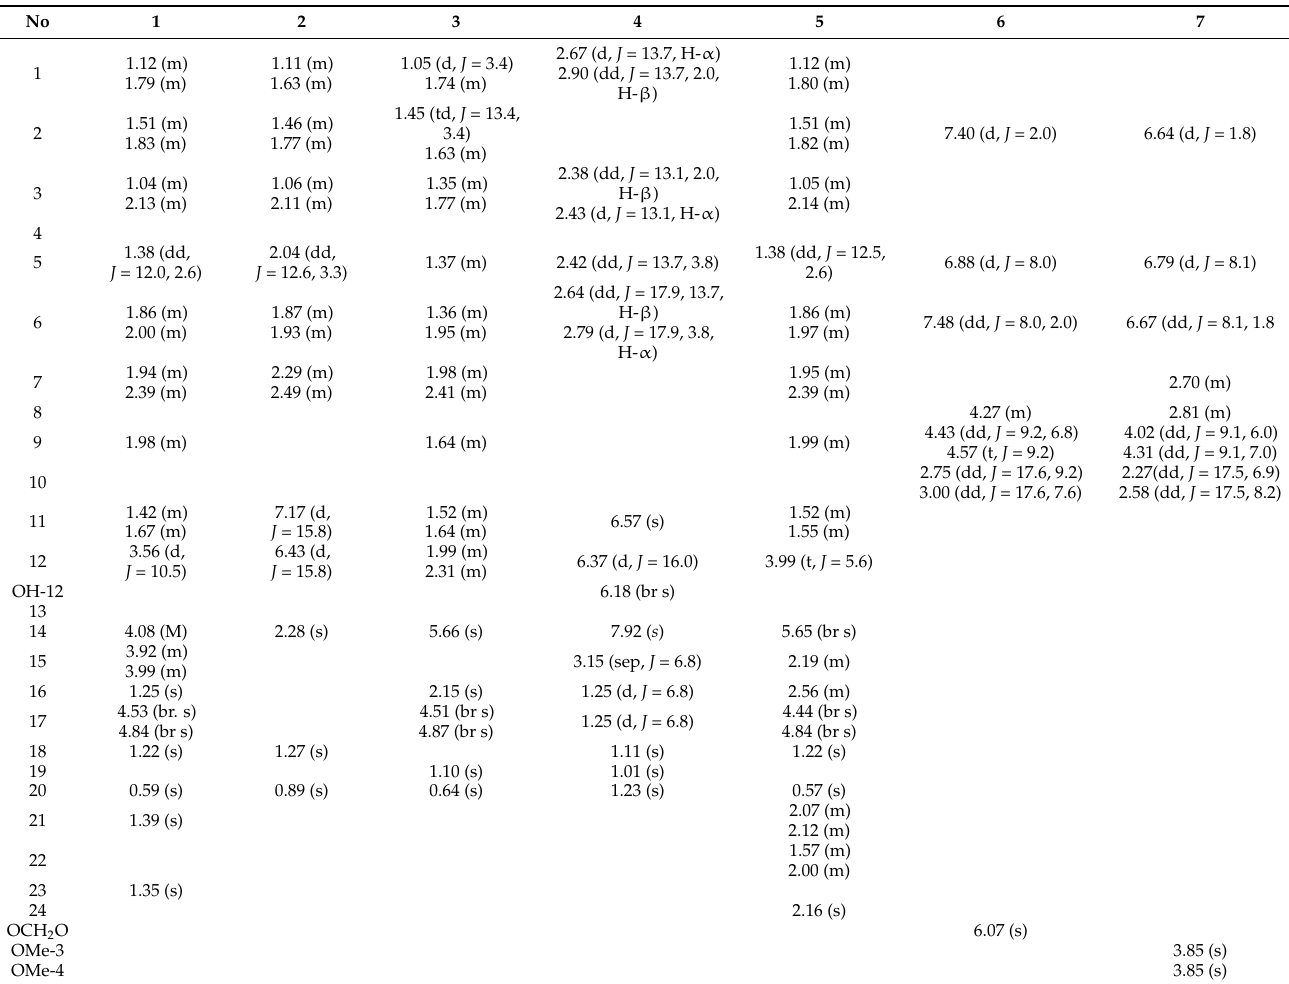
Table 1. 1 H NMR data for Compounds 1 – 7 in CDCl 3 ( δ in ppm, J in Hz, 500 MHz in CDCl 3